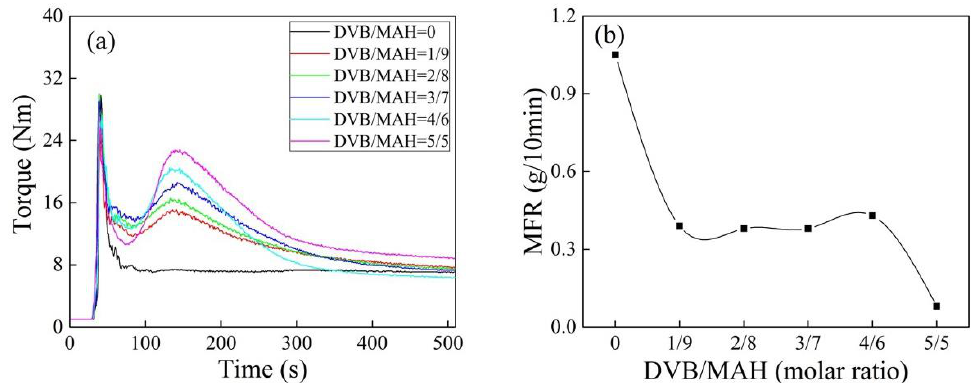
Figure 1. Torque/time spectra ( a ) and MFR ( b ) of isotactic polybutene (iPB)-g-maleic anhydride (MAH) at different divinyl benzene (DVB) concentrations ( T = 180 °C, dicumyl peroxide(DCP) = 0.6 phr, MAH = 6 phr).